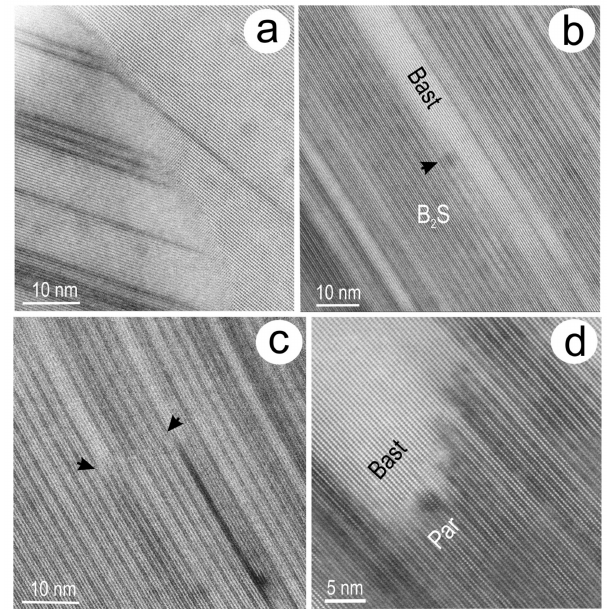
Figure 11. Details of grain boundaries ( a ) and changes in the slab stack perpendicular to the layer stacking direction ( c – e ) illustrating co-crystallisation and overprint, respectively. HAADF STEM images are taken down to [ − 1100] for ( a , d ) and to [10 − 10] for ( b , c ); ( a ) Stepwise, 1–2 atom-wide adjustment between two lamellae of bastnäsite with variable defects as slabs of parasite; ( b , c ) Apparent transformation of bastnäsite into B 2 S or parisite stacking sequences across the c axis shown as changes between B and S slabs on directions perpendicular to the c axis; ( d ) Irregular interface between bastnäsite and parisite suggesting replacement between the two phases. Note the lattice strain in the slabs along this interface. Bast—bastnäsite;